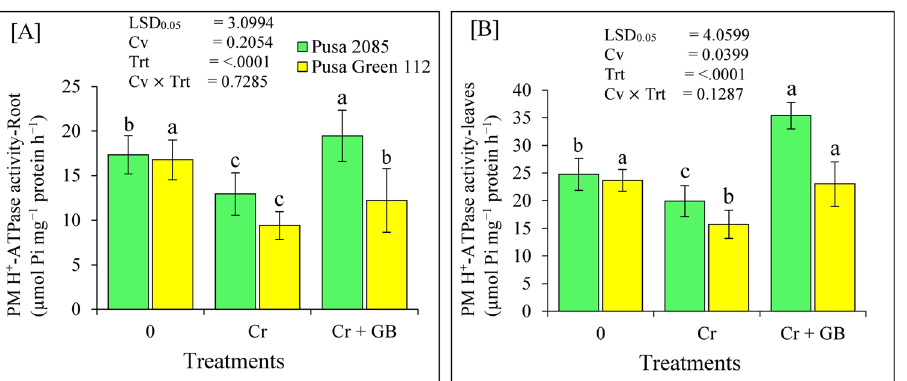
Figure 4. Effects of different stress levels of Glycine Betaine (GB) and Chromium (Cr), 0 and 120 μM Cr and 120 μM Cr + 100 mM (GB), on plasma membrane H + -ATPase activity (µmol Pi mg −1 protein h −1 ) in the roots and leaves of both chickpea cultivars at 7 days of exposure (grown under hydroponics conditions). Generated data values are shown as the mean of five replicates ± SE. The error bars indicated by the different letters represent significant differences, as tested by the least significant difference test ( p <